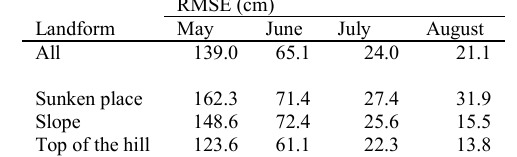
Table 2. RMSE values of maximum height derived from UAV data against maximum height derived from vegetation survey in different landforms; all, sunken place, slope and top of the hill 3.2.4 Comparison of mean growth length between the